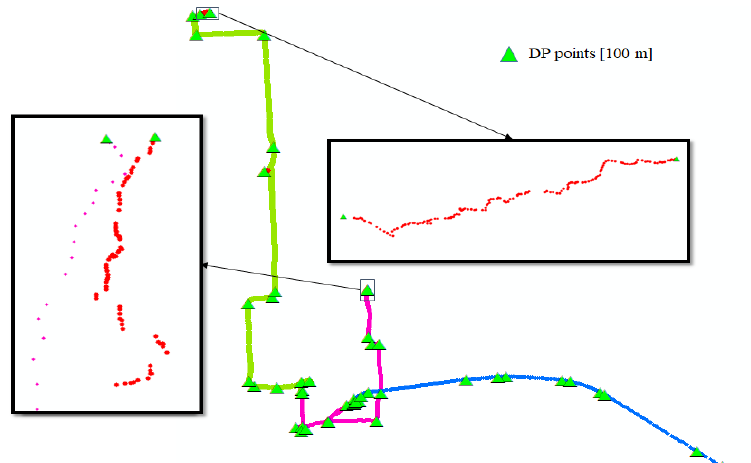
Figure 8 . DP trajectory compression with a threshold of 100